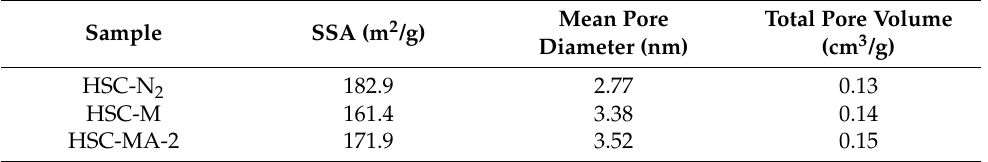
Table 3. BET surface specific area (SSA) and pore structure of biochars.